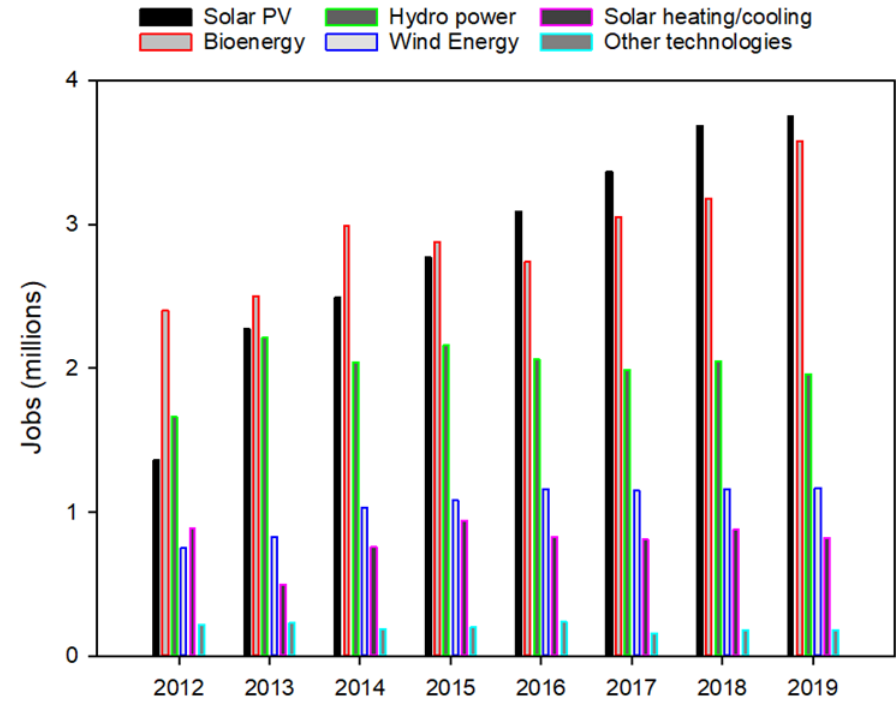
Figure 11. Global renewable energy employment by technology from 2012 – 2019 [139].